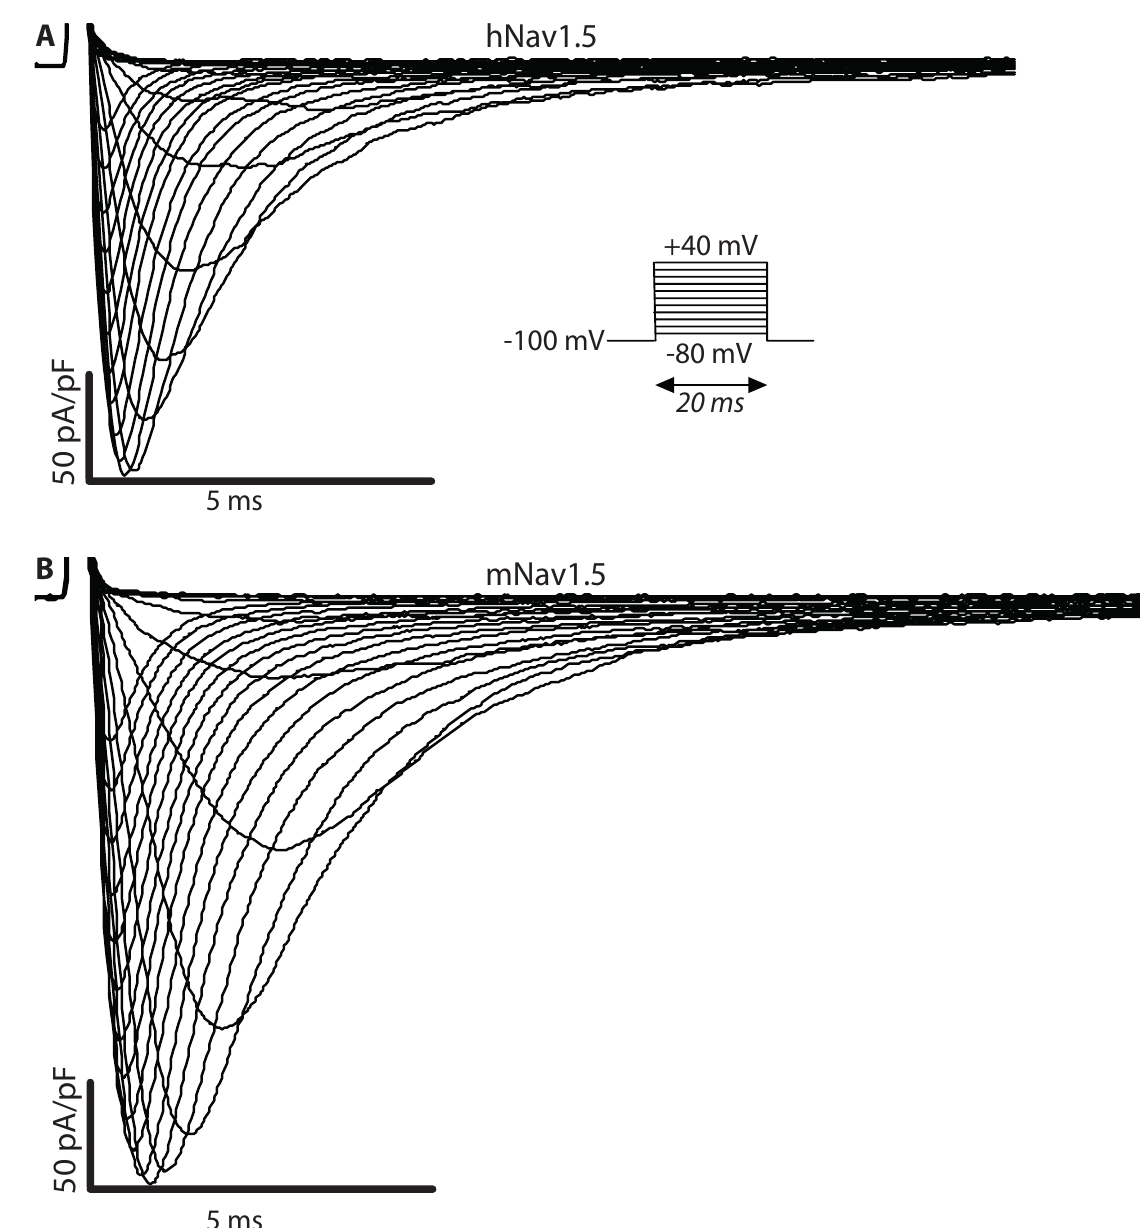
Figure 1. Representative I recordings following the current voltage (I/V)-protocol described in the Methods . ( A ) Voltage-dependent Na currents measured for hNa 1.5 expressed in a HEK293 cell. ( B ) Data from the same protocol for mNa v